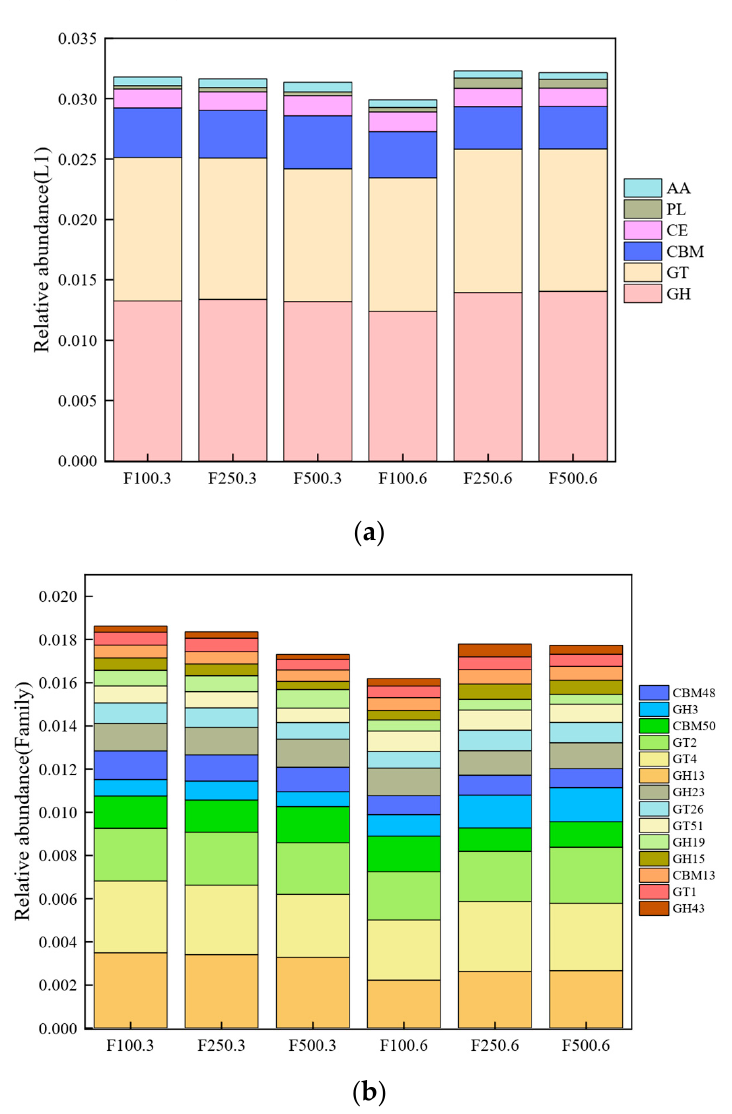
Figure 3. Relative abundance of the CAZymes at the L1 ( a ) and family ( b ) levels.